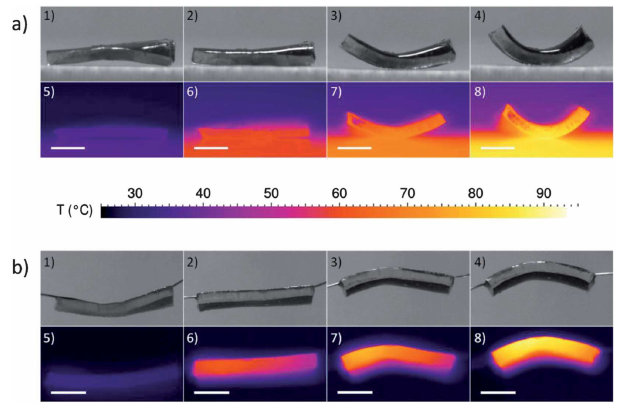
Figure 16. Bending actuation of LCE/ poly(3,4-ethylenedioxythiophene):poly(styrenesulfonate) (PEDOT:PSS) bilayer actuators. ( a ) Direct heating experiment using a Peltier element. Camera frames taken ( 1 ) at room temperature, ( 2 ) at the nematic–isotropic transition onset, ( 3 ) during the transition, and ( 4 ) at a temperature higher than the temperature transition. ( 5 – 8 ) Corresponding thermal infrared camera images. ( b ) Joule heating experiment. Camera frames taken at ( 1 ) room temperature, ( 2 ) at the nematic–isotropic transition onset, ( 3 ) during the transition, and ( 4 ) at a temperature higher than the temperature transition. ( 5 – 8 ) Corresponding thermal infrared camera frames (scale bar: 1 mm). Reproduced with permission from the authors of [89]. Copyright (2018) The Royal Society of